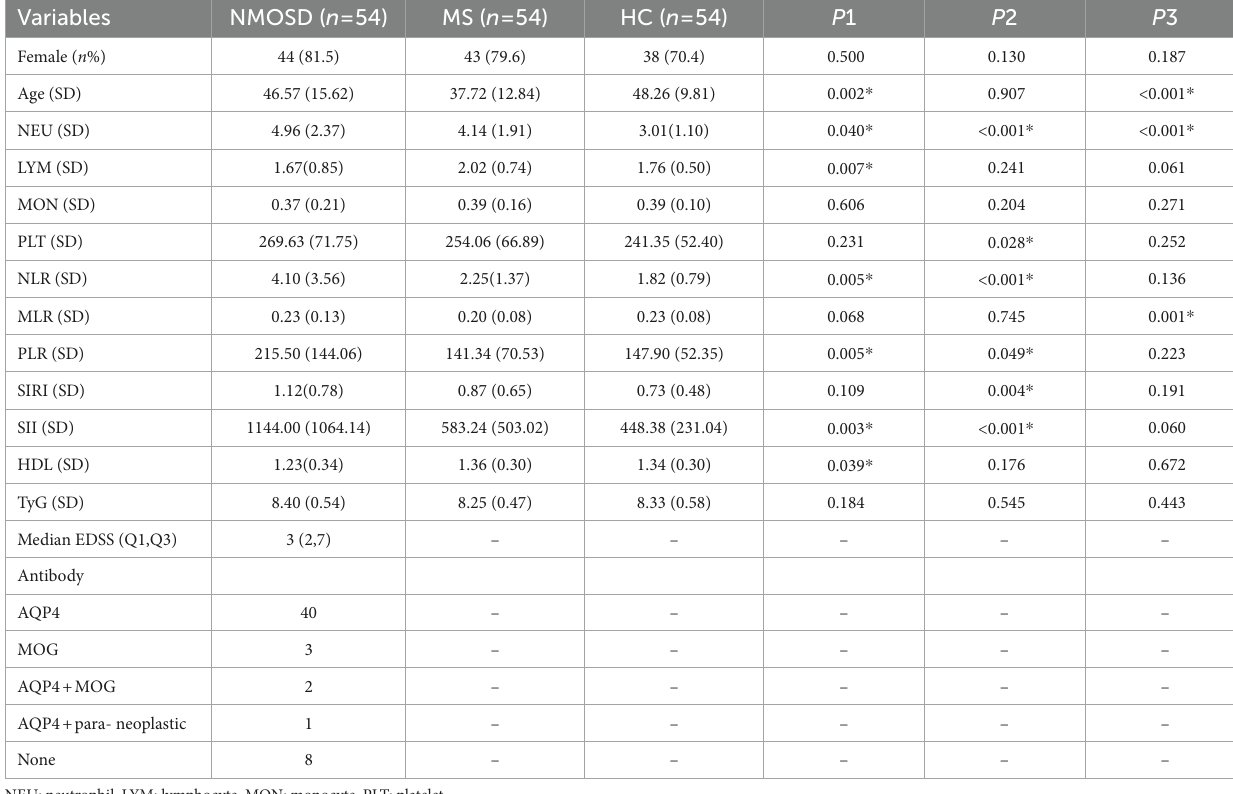
TABLE 1 Comparison of blood indexes between the three groups.